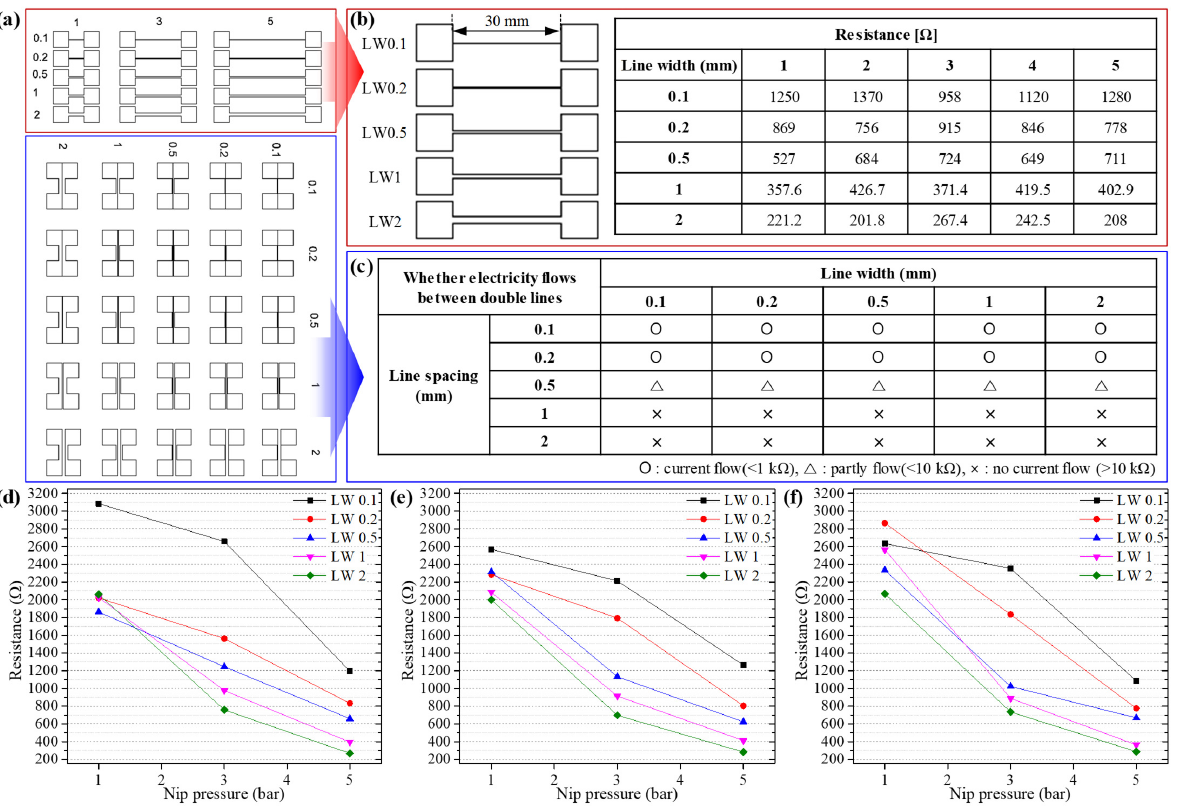
Figure 6. Experimental selective calendering for line and line spacing patterns: ( a ) design patterns for line and line spacing, ( b ) the resistance measurement of the line pattern with widths of 0.1, 0.2, 0.5, 1, and 2 mm, ( c ) measured resistance range from line spacing patterns with 0.1, 0.2, 0.5, 1, and 2 mm. The resistance of single line pattern with respect to the nip pressure at web speeds of ( d ) 1, ( e ) 3, and ( f ) 5 m/min.